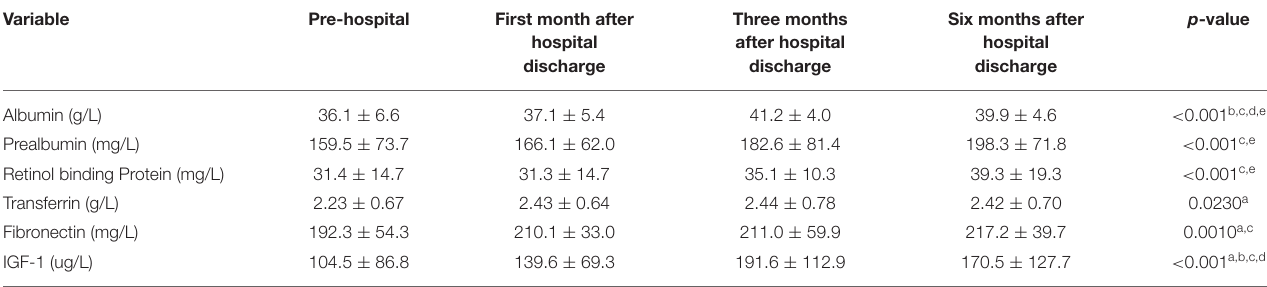
TABLE 4 | Other nutritional parameters.